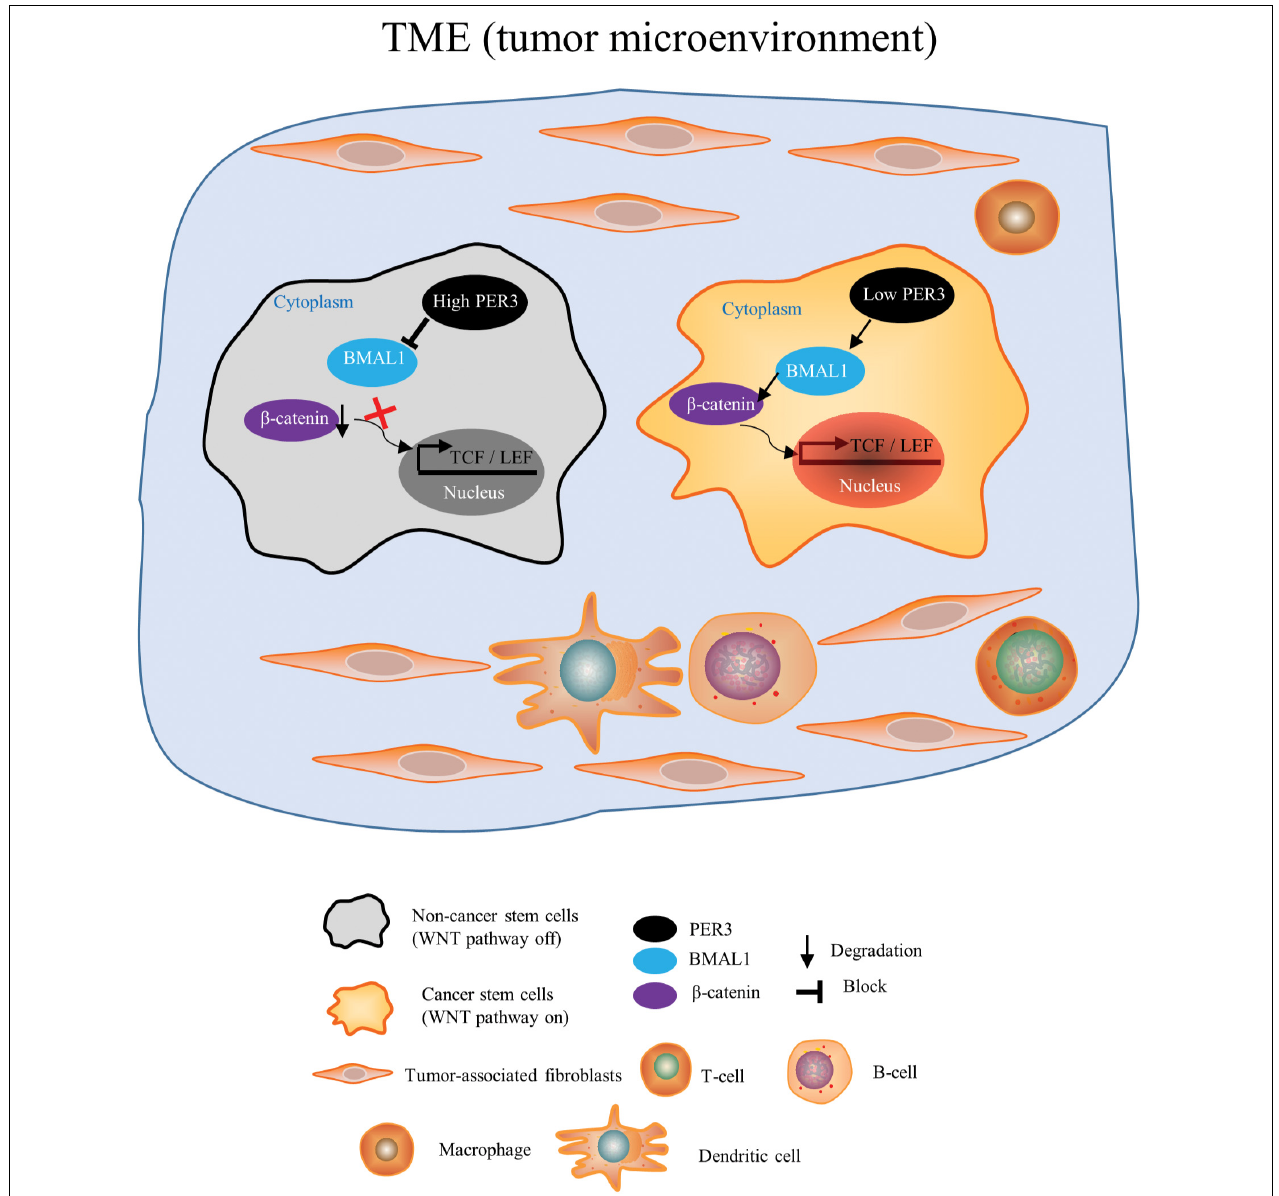
FIGURE 7 | A model depicting that PER3 regulates stemness of PCSCs via WNT/ β -catenin pathway. Our results suggest that in PCa TME, PCa DN cells (non-PCSCs) bear high levels of PER3, which downregulates the expression of BMAL1 and prevents the translocation of β -catenin from cytoplasm into nucleus to activate WNT/ β -catenin pathway. On the other hand, PCa DP cells (PCSCs) have low levels of PER3, which upregulates BMAL1 expression, leading to the translocation of β -catenin from cytoplasm into nucleus to eventually activate WNT/ β -catenin signaling